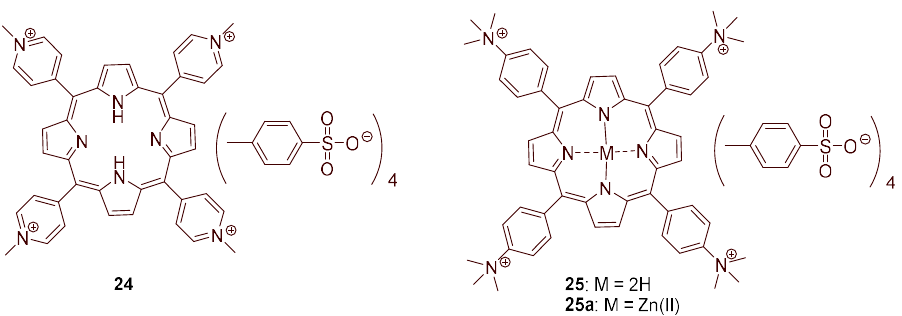
Figure 18. Tetracationic porphyrin derivatives used as PS in Bonnett and Galia studies [164] .